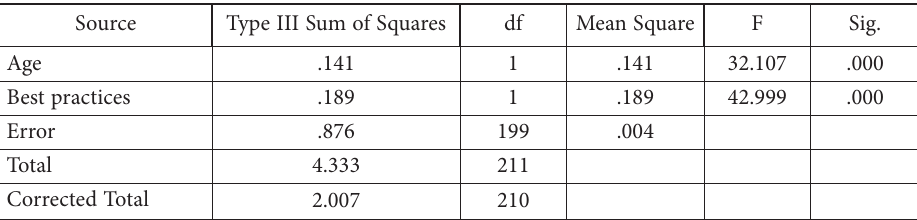
Table 6. Parameter Estimates (Dependent Variable: Employee turnover (source: own research) 95% Confidence Interval Parameter B Std. Error t Sig. Lower Bound Upper Bound Intercept .585 .049 11.991 .000 .489 .681 [gender=1= man] .028 .012 2.288 .023 .004 .053 [gender=2= woman] 0 . . . Practice –.023 .007 –3.118 .002 –.008 Age –.005 .001 –5.666 .000 –.007 –.003 Best practice –.039 .006 –6.557 .000